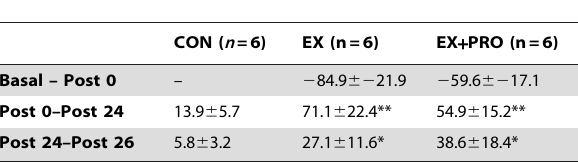
Table 4. Absolute change in muscle glycogen.